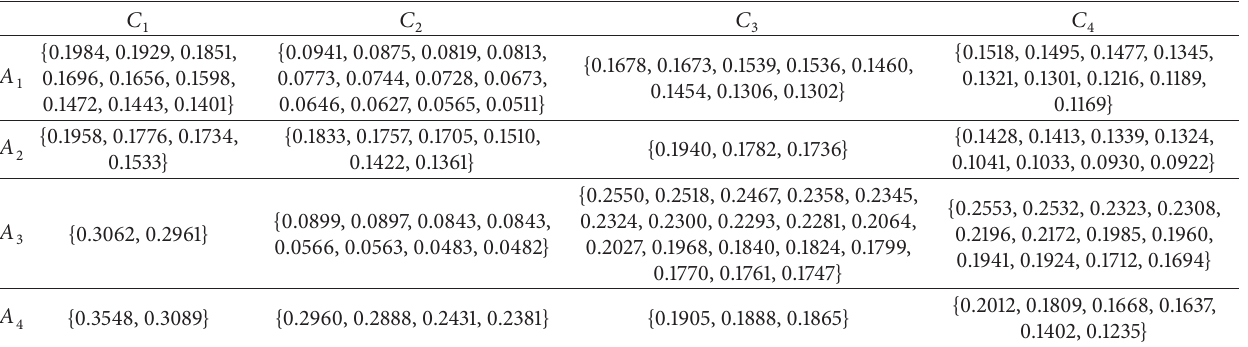
Table 8: The collective hesitant fuzzy decision matrix R .